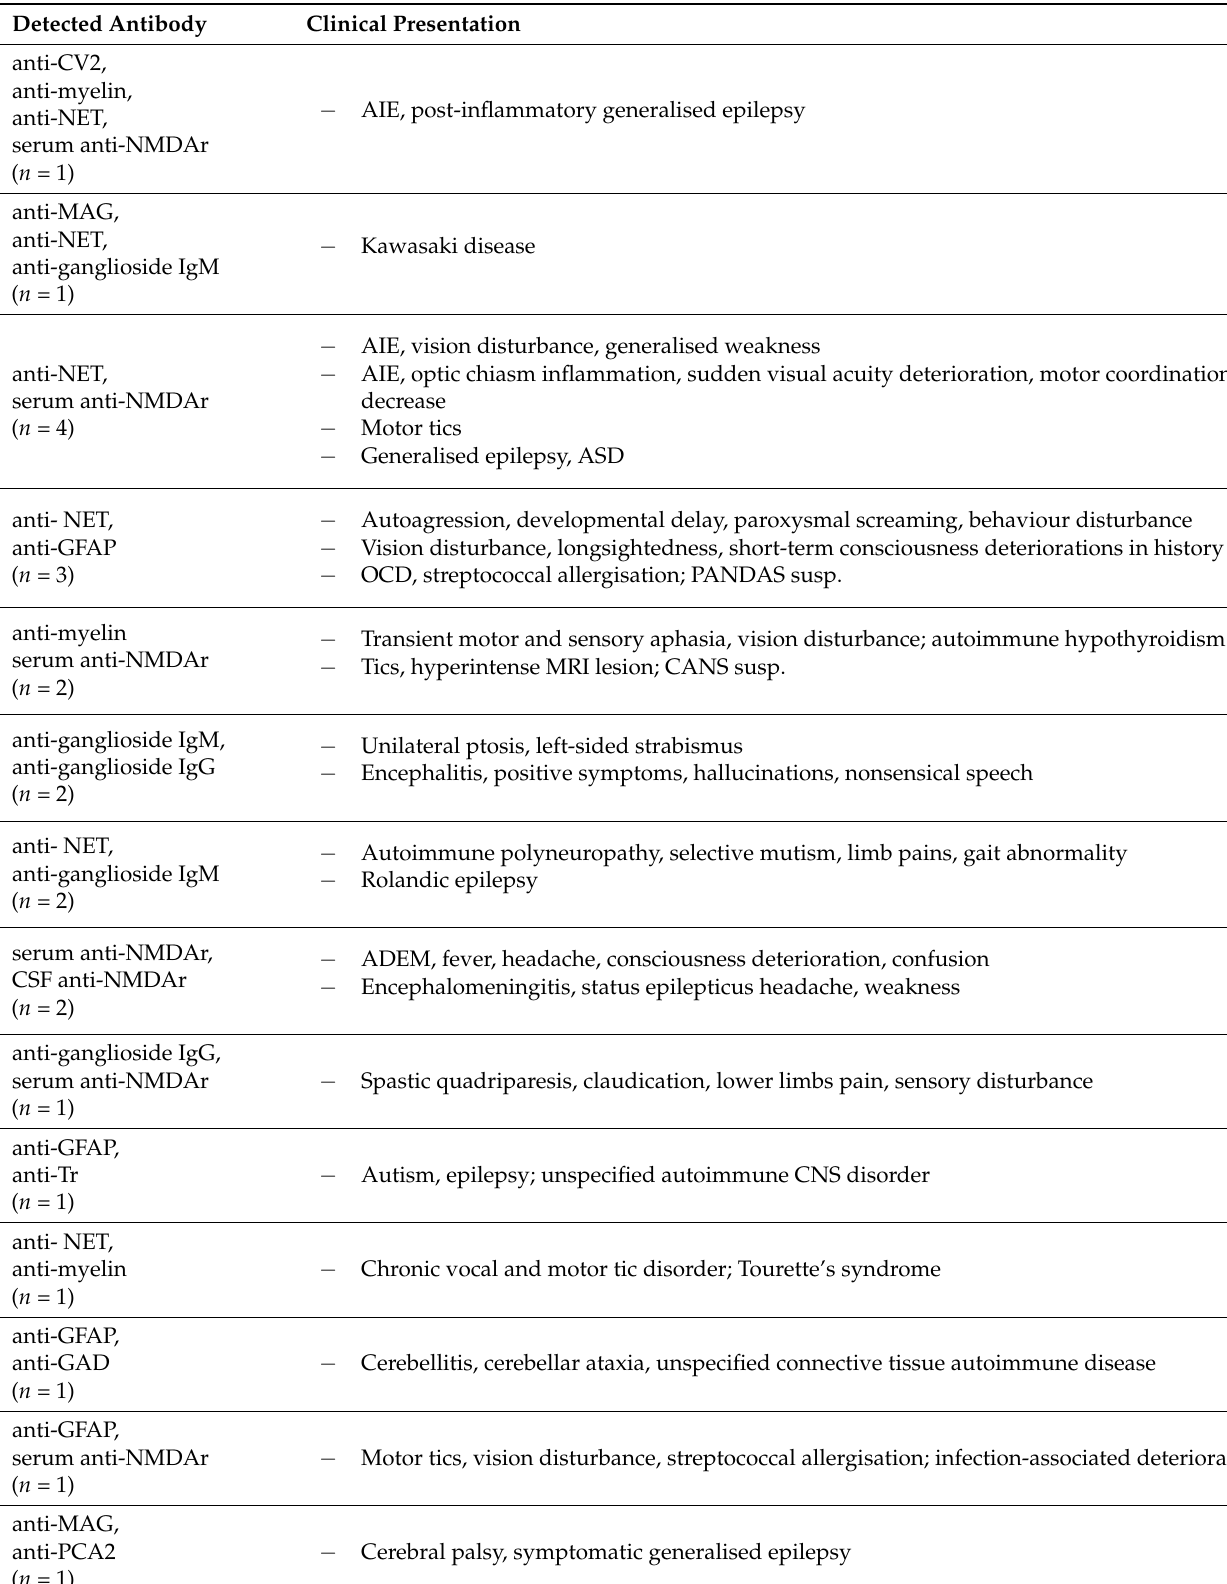
Table 1. Clinical description of patients divided due to autoantibody